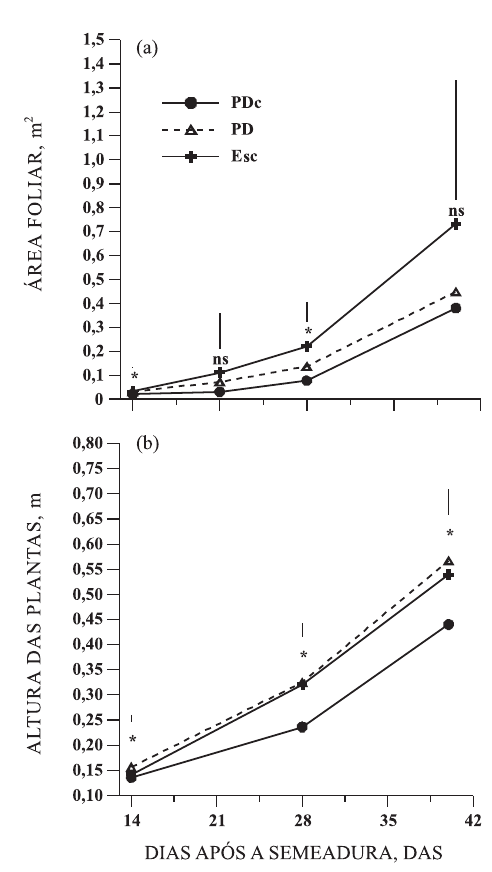
Figura 5. Variação da área foliar (a) e da altura (b) do feijoeiro ao longo do ciclo da cultura. Barras verticais comparam os valores de área foliar e altura de plantas pelo teste DMS (5 %). (ns: não- significativo; *: